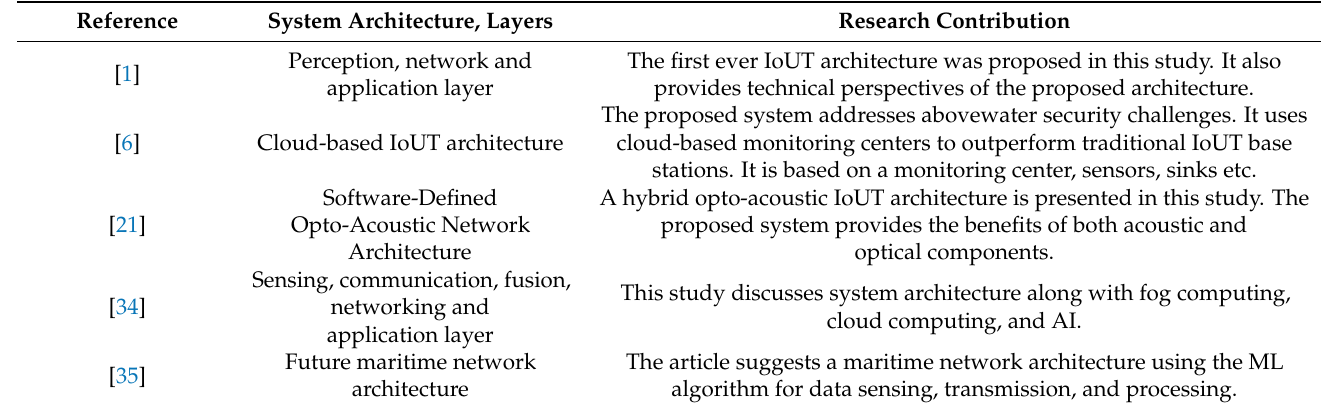
Table 3. Research on IoUT